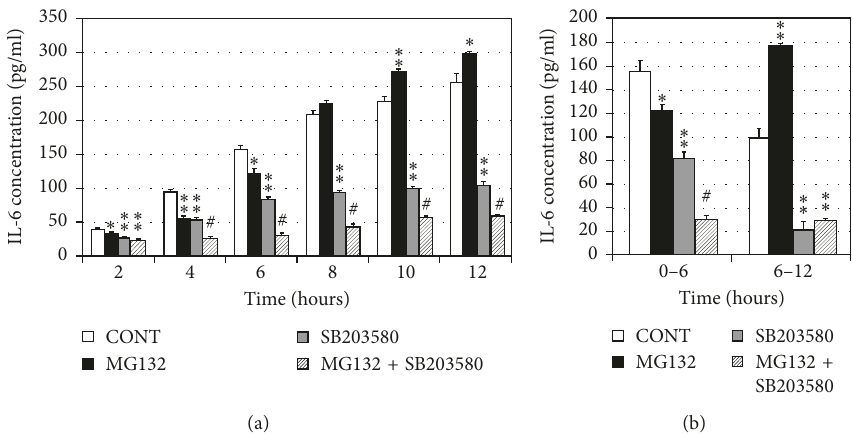
Figure 7: Inhibition of p38 MAPK blocks proteasome inhibition-induced upregulation of IL-6. (a) ARPE-19 cells were cultured in the presence or absence of MG132 (10 μ M), SB203580 (10 μ M), or MG132 plus SB203580 for 2, 4, 6, 8, 10, and 12 h. Levels of IL-6 in the media were determined by ELISA. The results are the mean ± SD. ∗ p < 0 . 05 and ∗∗ p < 0 . 01 as compared with the control; # p < 0 . 05 as compared with the control or SB203580 alone. (b) Levels of IL-6 in the medium were detected by ELISA at 0 h–6h and 6 h–12h in the presence or absence of MG132 (10 μ M), SB203580 (10 μ M), or MG132 plus SB203580. The results are the mean ± SD. ∗ p < 0 . 05 and ∗∗ p < 0 . 01 as compared with the control; # p < 0 . 05 as compared with the control or SB203580 alone.